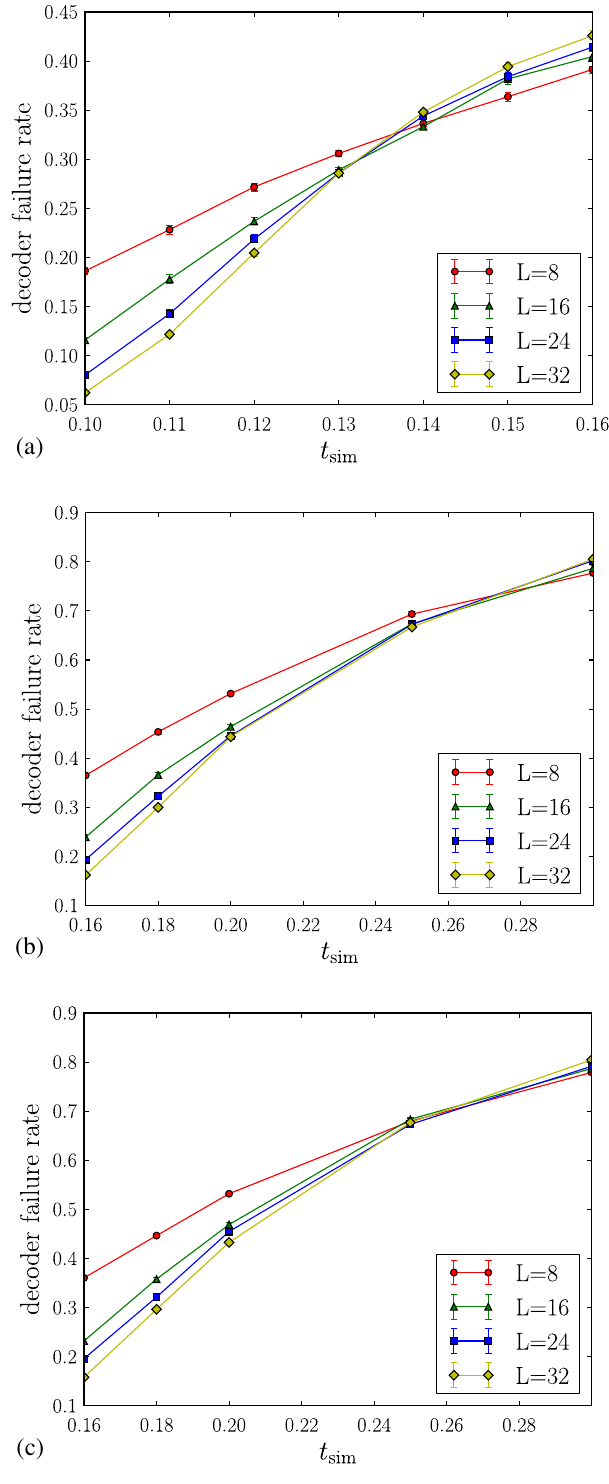
FIG. 8. Logical j 0 i state failure probability against simulation time (average errors per edge) for three different noise models: (a) ψ particle creation only, γ ψ c ≠ 0 ; p d ¼ 0 ; (b) decoherence- dominated noise, γ ψ c ¼ γ σ c ≠ 0 ; p d ¼ 1 ; and (c) hopping- dominated noise, γ h ≫ γ ψ c ¼ γ σ c ≠ 0 ; p d ¼ 0 . Each plot is for the Ising fusion code using the PMA-type decoder.